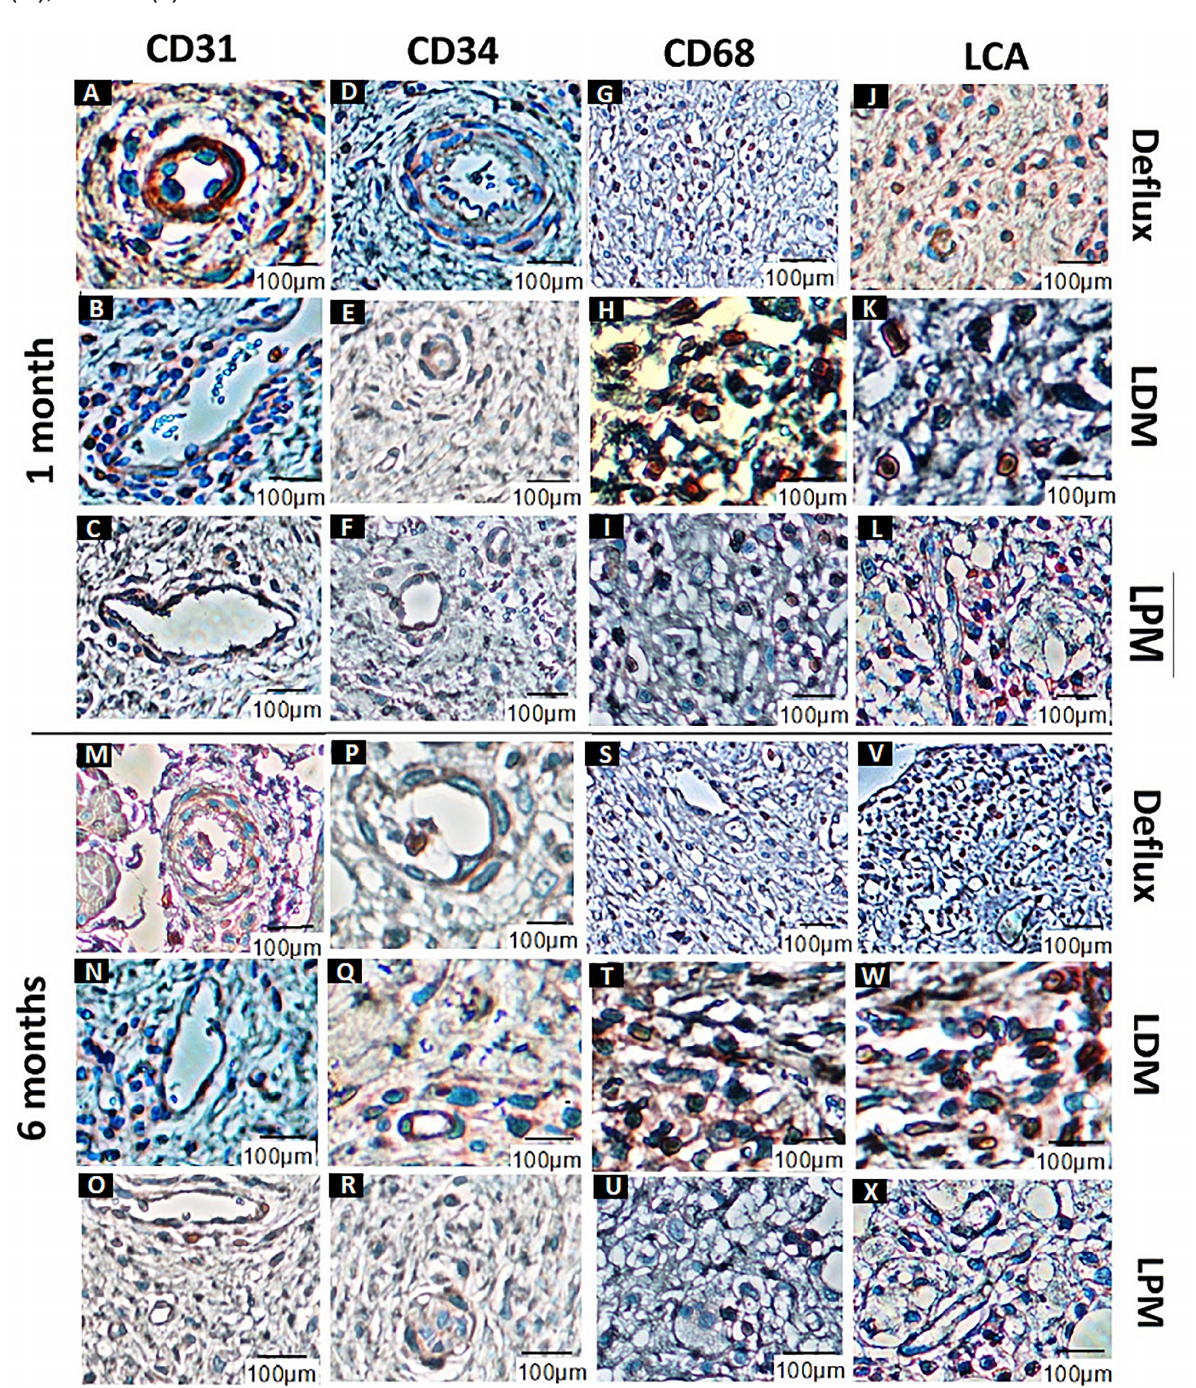
Figure 4 - IHC staining after 1 month of follow-up: CD31staining in Deflux (A), LDM (B), and LMP (C), CD34 staining in Deflux (D), LDM (E), and LMP (F), CD68 staining in Deflux (G), LDM (H), and LMP (I), and LCA staining in Deflux (J), LDM (K), and LMP (L). IHC staining after 6 months of follow-up: CD31staining in Deflux (M), LDM (N), and LMP (O), CD34 staining in Deflux (P), LDM (Q), and LMP (R), CD68 staining in Deflux (S), LDM (T), and LMP (U), and LCA staining in Deflux (V), LDM (W), and LMP